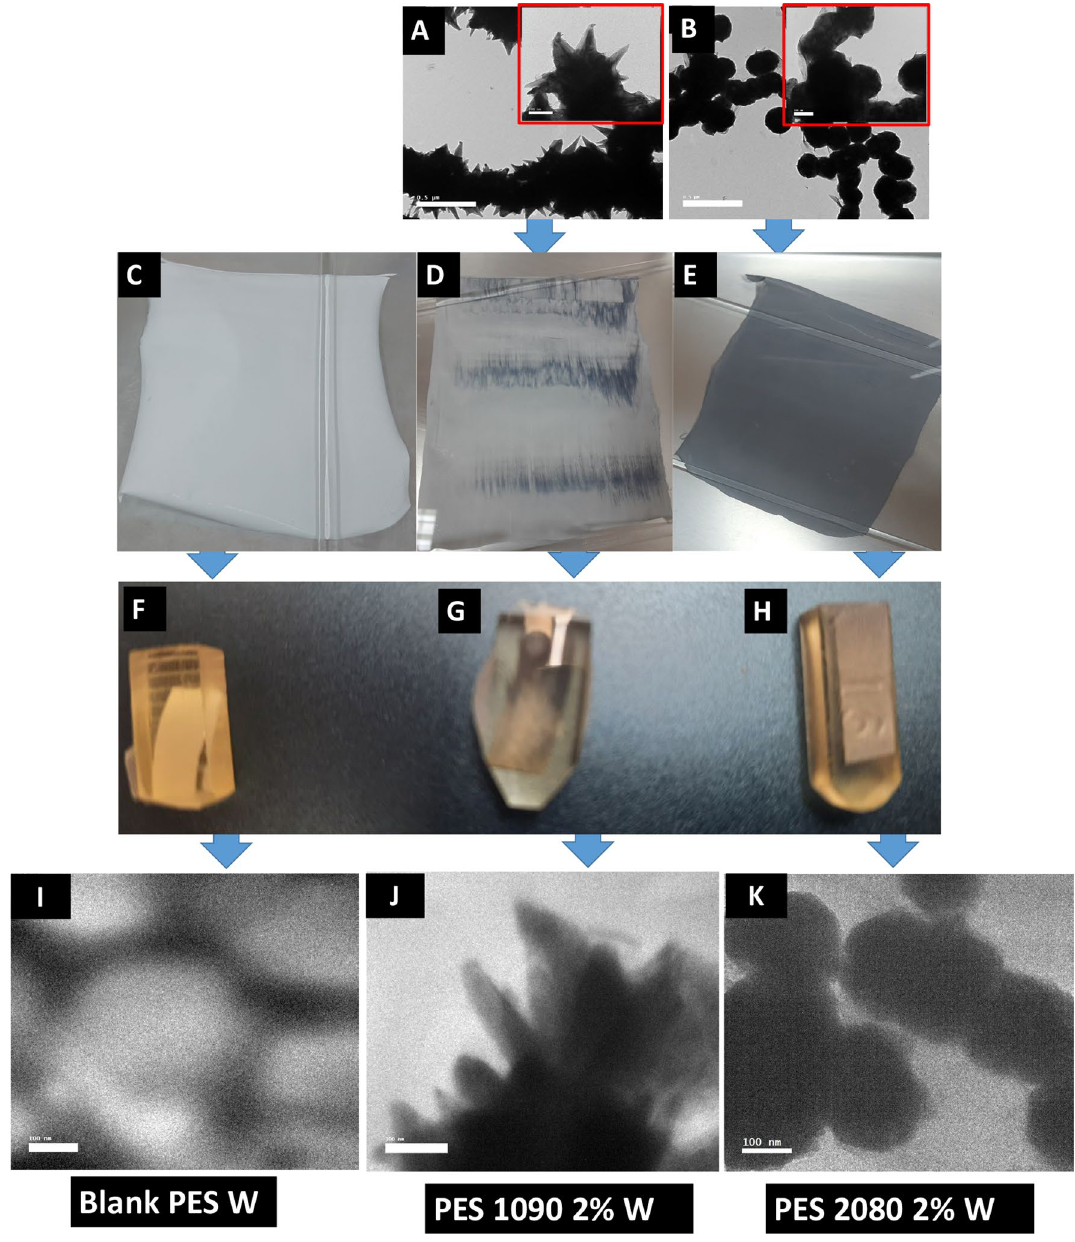
Figure 3. TEM images (0.5 µm and 100 nm bar scales) of the used iron–nickel alloys; starfish-like Fe 10 Ni 90 ( A ) and necklace-like Fi 20 Ni 80 ( B ). Photos of the Blank PES ( C ) and the magnetic mixed matrix PES membranes; ( D ) Fe 10 Ni 90 and ( E ) Fi 20 Ni 80 , and Photos of the prepared epoxy blocks contained the fabricated magnetic mixed matrix PES membranes (blank PES; F , mixed matrix PES membranes; G,H ). TEM images (100 nm bar scale) of the blank PES ( I ) and the mixed matrix PES membranes ( J,K ) inside the epoxy